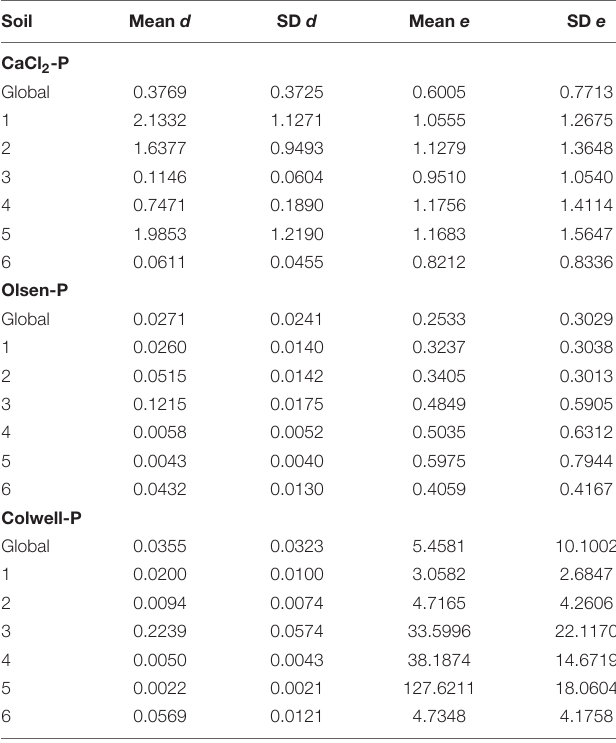
TABLE 4 | The CaCl 2 -P, Olsen-P and Colwell-P posterior statistics of d and e in isolation from each other, on a global ( d 0 and e 0 ) and soil ( d s and e s ) level.